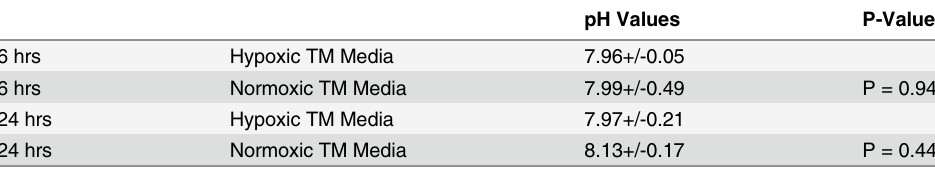
Table 1. pH values of media from NTM cells subjected to